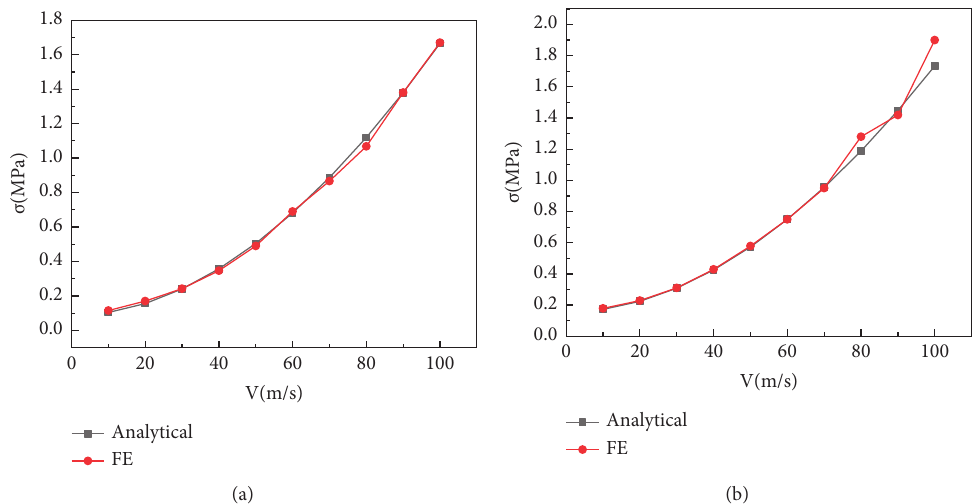
Figure 16: The dynamic collapse stress of DHHs under uniaxial compression, N � 5 and ρ � 5%. (a) Impact in the x direction. (b) Impact in the z